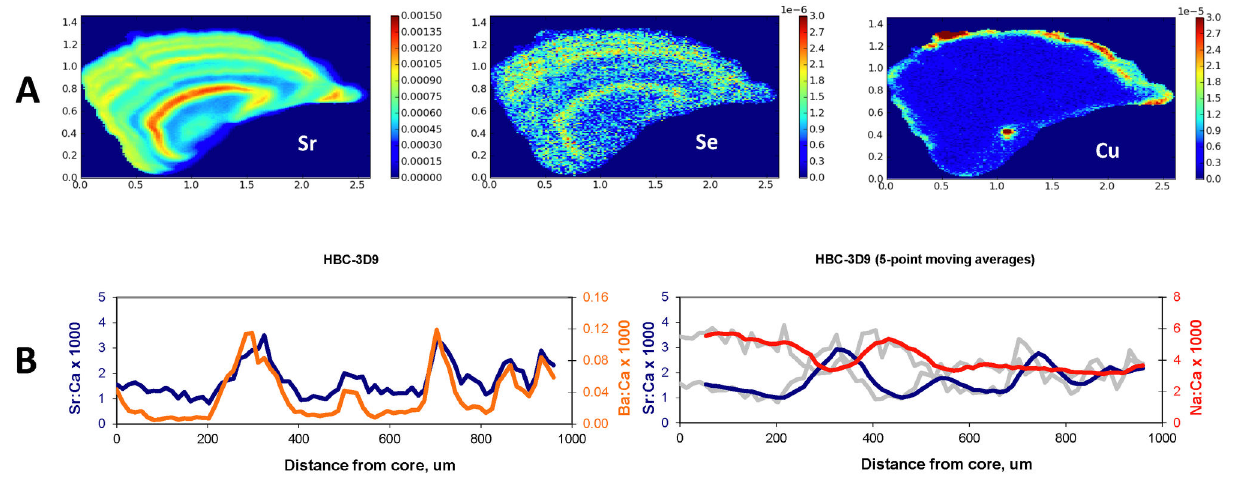
Figure 6. A. Trace elemental maps generated by SXFM . Note the concordance of SrSr and Se and the elevated Cu in the core region. B. Trace elemental transects of SrSr, Ba, and Na in ratio to Ca measured with LA-ICPMS. Note qualitative similarities of SrSr:Ca and Ba:Ca to the patterns in the trace elemental maps, and the inverse relationship of Na:Ca to SrSr:Ca up to approximately 550